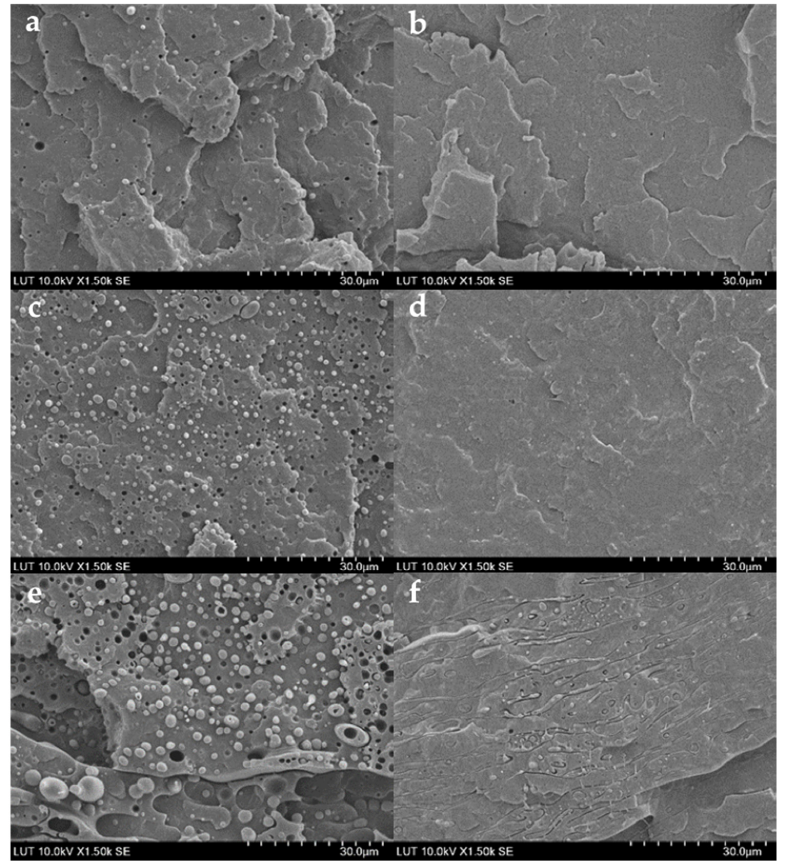
Figure 4. SEM images of ( a ) PP90/PCL10, ( b ) PP90/PCL10C1.25, ( c ) PP80/PCL20, ( d ) PP80/PCL20C1.25, ( e ) PP70/PCL30, and ( f ) PP70/PCL30C1.25 [30].